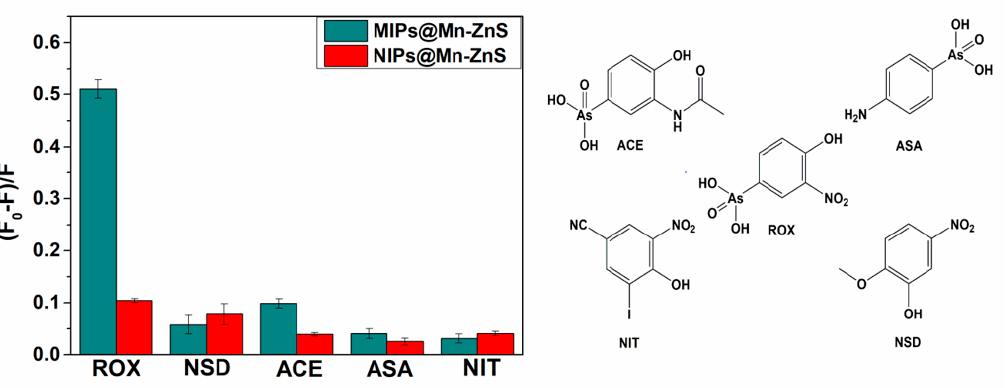
Figure 8. (F 0 − F)/F of MIPs@Mn-ZnS QDs and NIPs@Mn-ZnS QDs in the presence of ROX, NSD, ACE, ASA and NIT (the concentration of analyte is 0.5 µ M for ROX and its analogues).